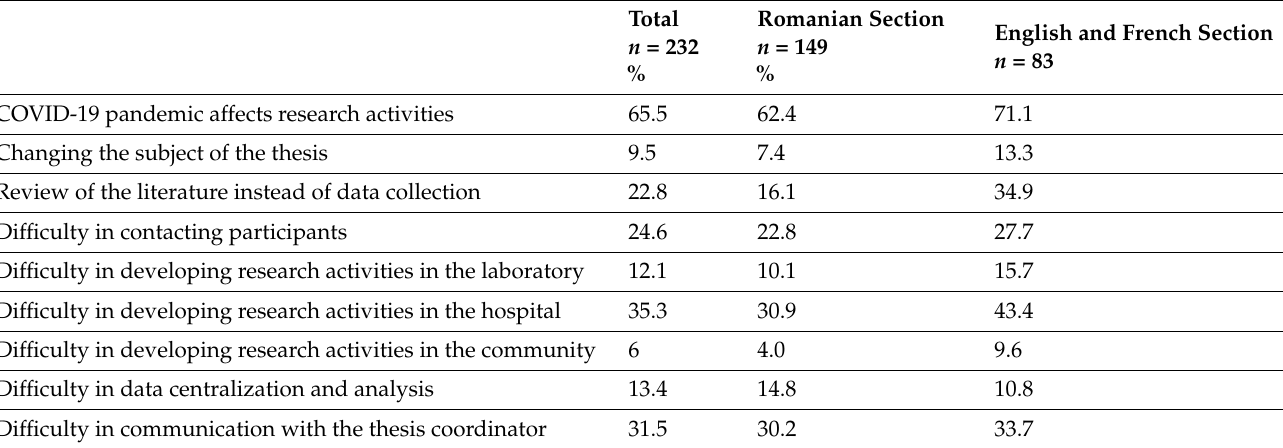
Table 1. Impact of COVID-19 pandemic regarding research activities conducted by students in their final